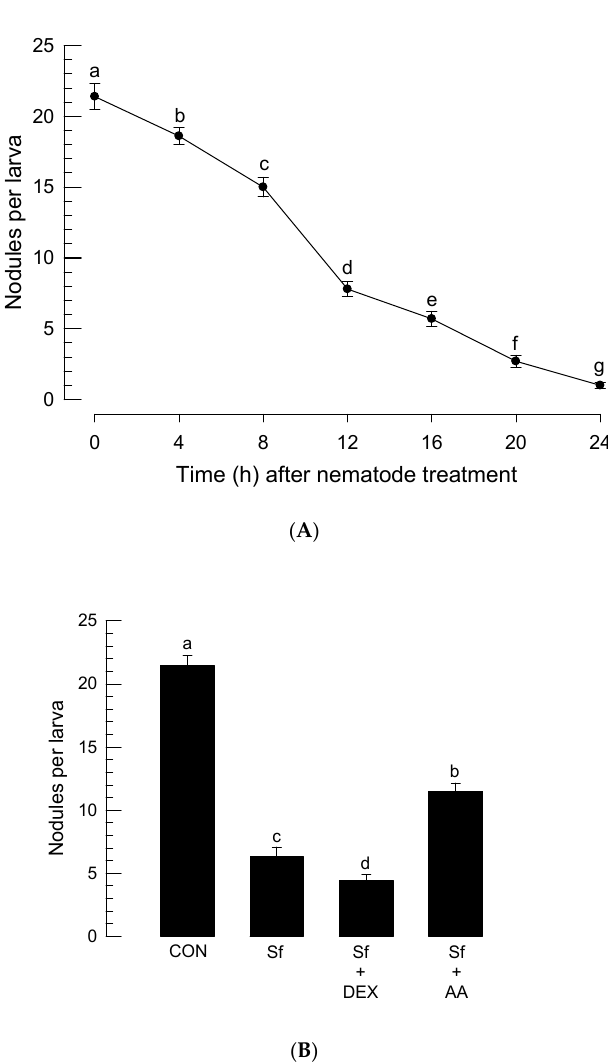
Figure 5. Suppression of hemocyte nodule formation in P. xylostella larvae infected with S. feltiae K1. ( A ) Temporal change in immune response after nematode infection. Fourth instar larvae of P. xylostella were treated with 80 IJs per larva. At di ff erent time points, these treated larvae were injected with E. coli (1.86 × 10 4 cells / larva). Nodules were counted at 8 h after the bacterial treatment. ( B ) E ff ect of arachidonic acid (‘AA’, 10 µ g / larva) or dexamethasone (‘DEX’, 10 µ g / larva) addition on nodulation of P. xylostella larvae infected with S. feltiae K1 (‘Sf’). Each treatment was replicated three times and each replication used 10 individual larvae per treatment. Di ff erent letters above standard error bars indicate significant di ff erence among means at Type I error = 0.05 (LSD